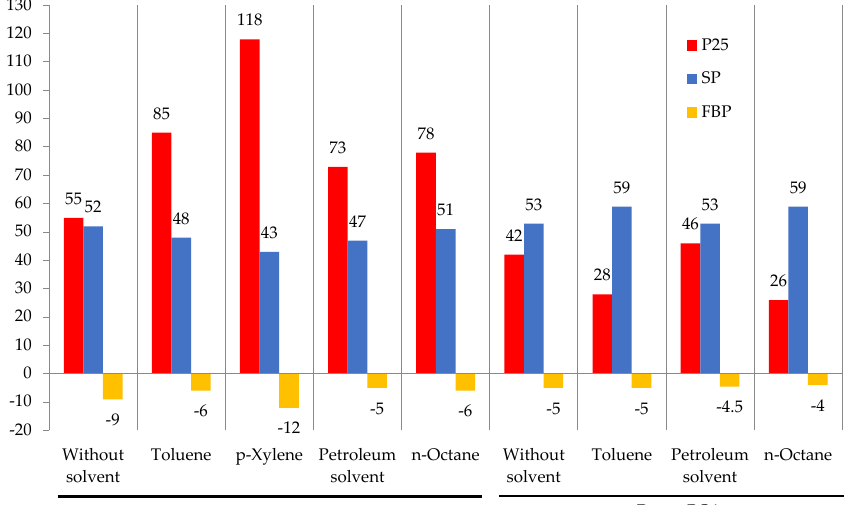
Figure 5. The effect of solvent on the modification process; solvent amount 20.0 kg/100 kg raw; formalin amount (including formaldehyde) 10.0 (3.7) kg/100 kg raw; catalyst amount (HCl) 2.5 kg/100 kg raw; temperature 120 °C; duration 3 h. (Figure 5). When modifying oxidized bitumen (OB1) without solvent, the softening point increased by 7 °C, and when using toluene, petroleum solvent, and n -octane, the softening